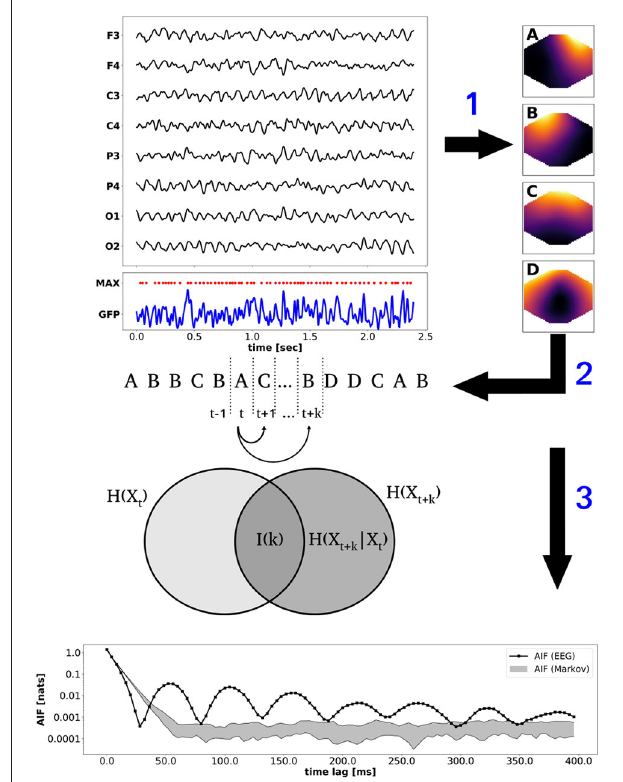
FIGURE 1 | Algorithm: the (top) panel shows a section of resting state EEG (1–40 Hz, black), the global field power (GFP, blue), and the local GFP maxima (red dots). EEG topographies at local GFP maxima are clustered by the modified K-means algorithm to obtain the n = 4 microstate maps A–D (step 1). Fitting the maps back into the EEG data set yields the microstate sequence (A,B,B,C,...) depicted below the EEG data (step 2). Step 3 illustrates information-theoretical analysis of the microstate sequence. Time-lagged mutual information I ( k ) for time lag k is illustrated by a Venn diagram. The (bottom) panel shows the periodic mutual information function (black) and the Markov confidence interval (gray area, α =